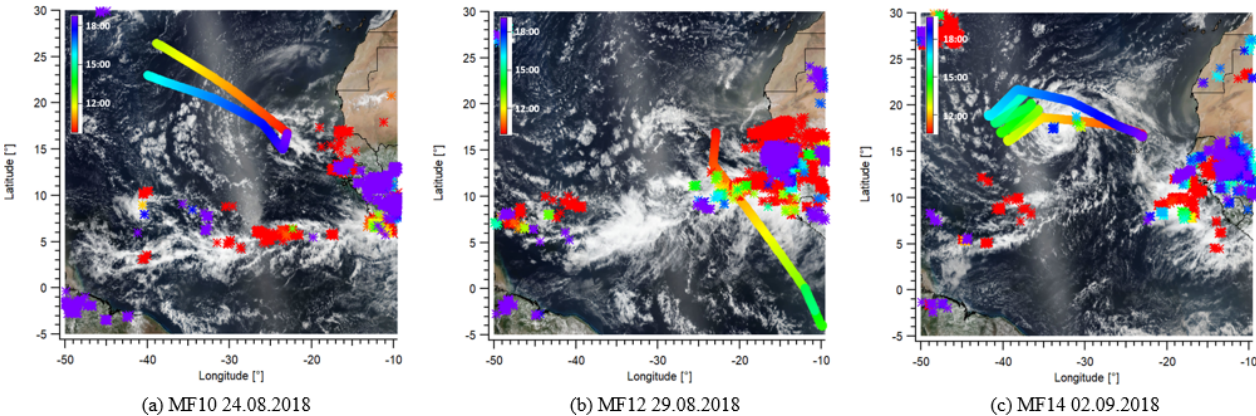
Figure 5. Lightning flashes shown as asterisks detected by the WWLLN on 24 and 29 August and 2 September 2018. Flashes and flight tracks are color-coded according to the time of day (Red shows morning hours and blue shows evening hours.) Background satellite images were obtained from the NASA Worldview application (NASA Worldview,